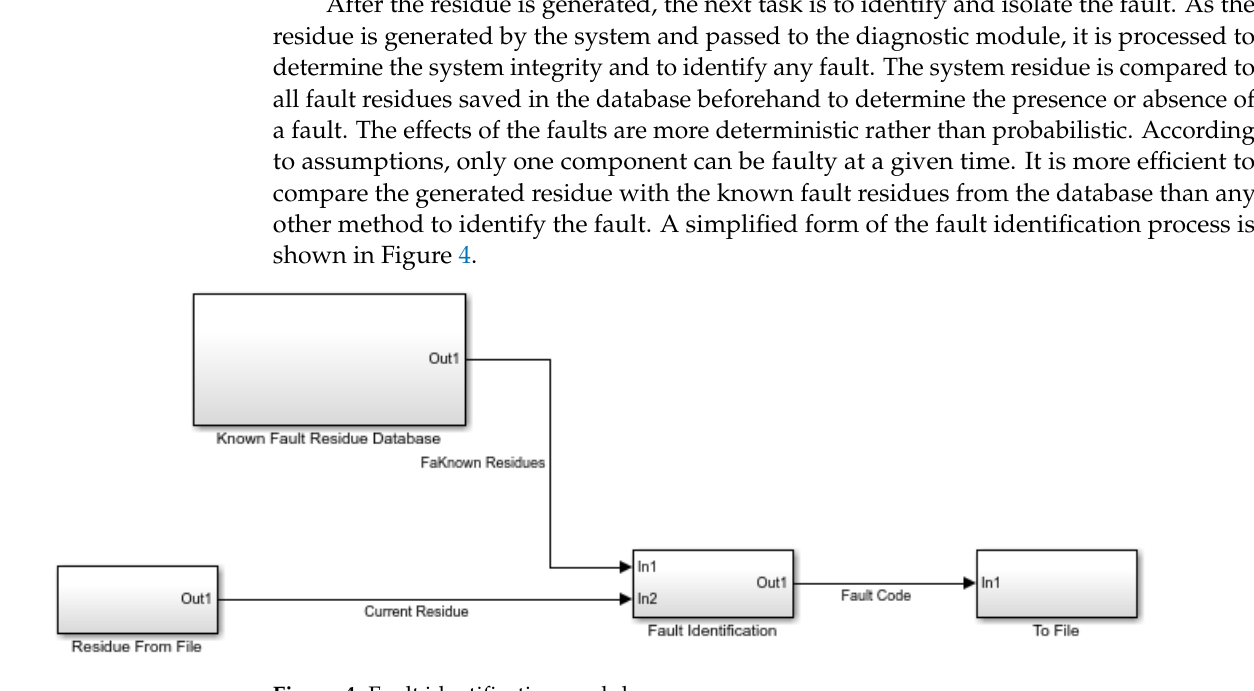
Figure 4. Fault identification